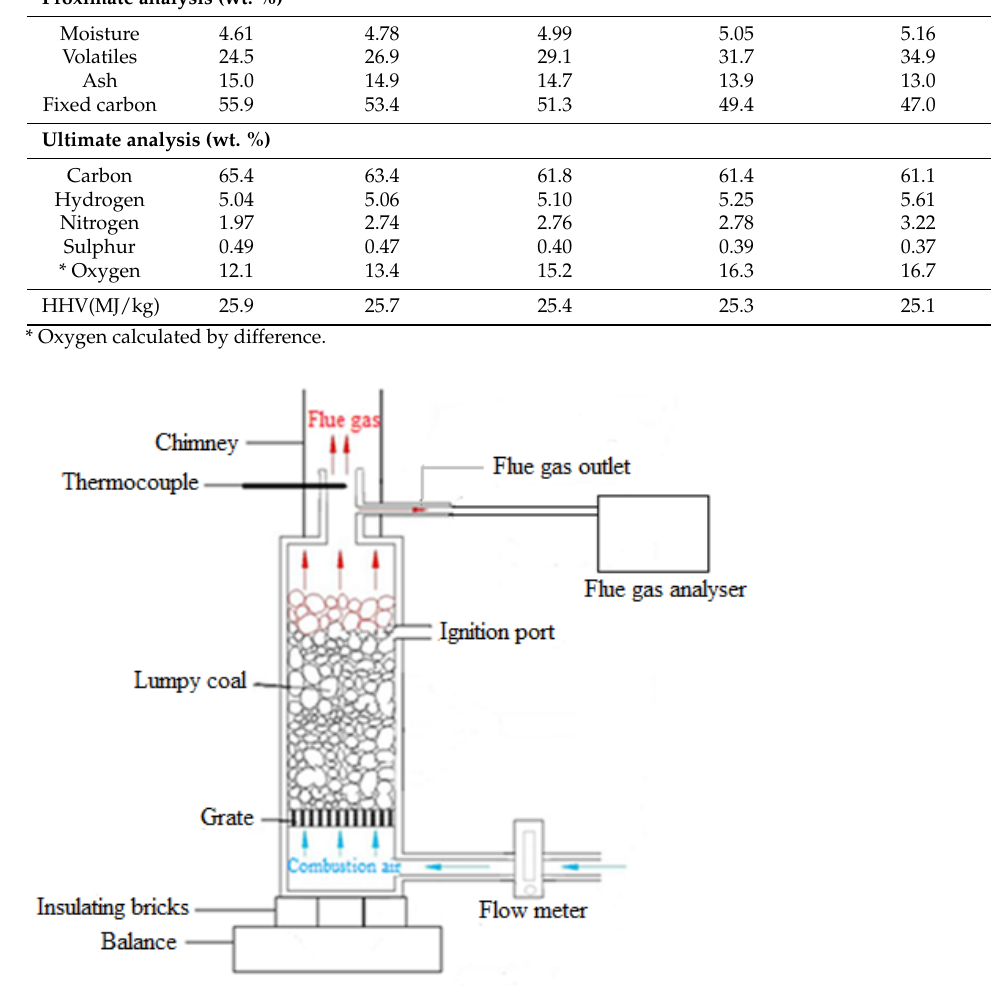
Figure 1. Schematic diagram of a fixed-bed combustion reactor